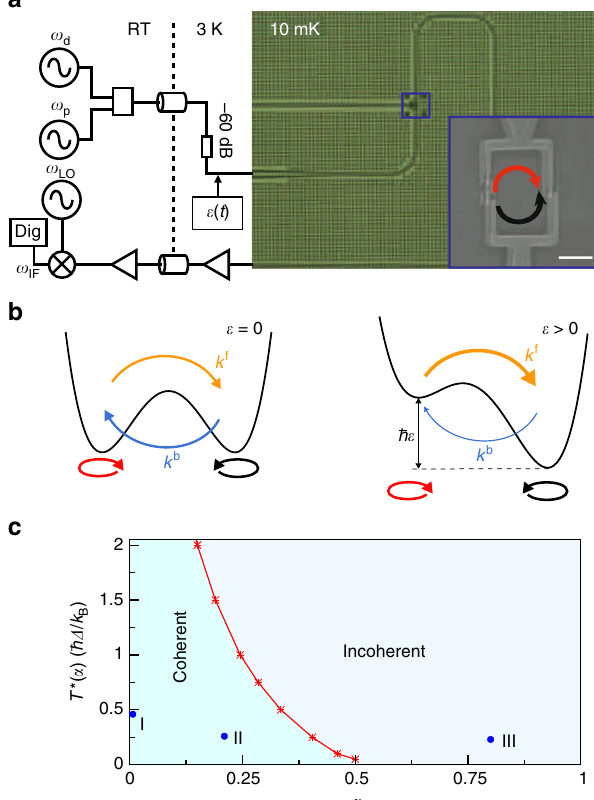
Fig. 1 Experimental setup and phase diagram of the symmetric spin-boson model. a Measurement, driving circuit schematic and optical micrograph of a device similar to the ones used in the experiment. A coplanar waveguide running across the chip plays the role of the bath coupled to the qubit. The inset is a scanning electron micrograph showing the qubit attached to the line. The scale bar is 2 μ m. Here and in panel b the red (black) arrow indicates clockwise (anticlockwise) circulating persistent currents. b Schematics of the double-well potential associated to the fl ux threading the qubit. In the absence of external driving sources the potential is symmetric and the forward and backward tunneling rates k f/b are equal. In the presence of a positive bias asymmetry ε , forward tunneling dominates over backward tunneling. c Dependence of the temperature T *( α ) for the crossover from the coherent to the incoherent tunneling regime on the coupling α . The red curve interpolates numerical results (asterisks) obtained within the nonperturbative NIBA. The dots labeled I, II, and III mark the positions in parameter space of the three devices used in this